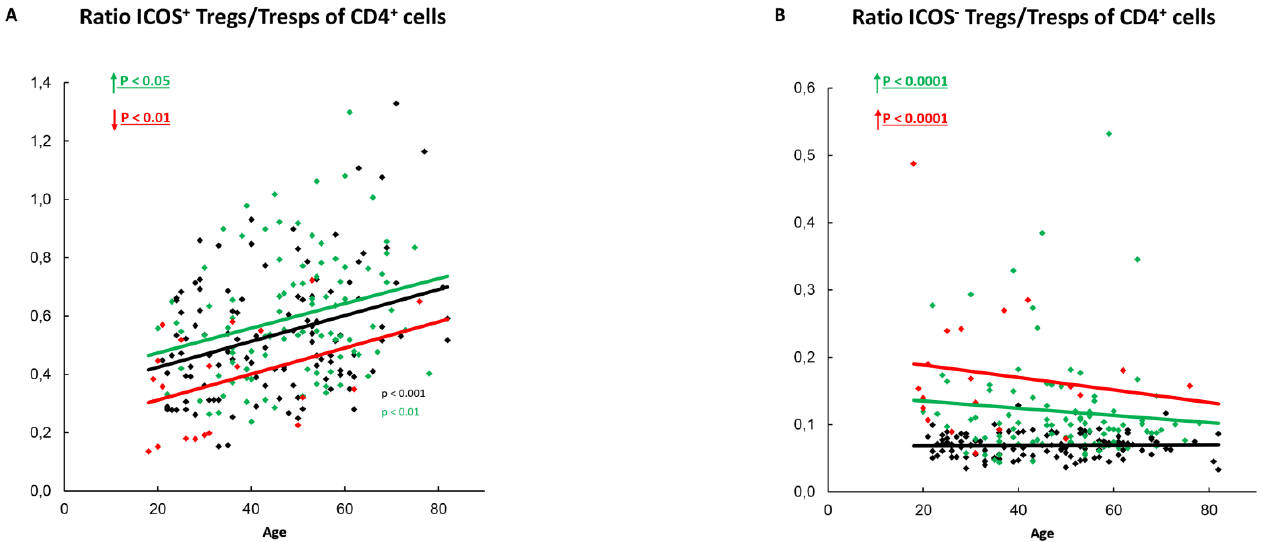
Figure 6. Ratio of ICOS + -Tregs/Tresps or ICOS − -Tregs/Tresps within total CD4 + -T-helper cells. The ratio of ICOS + - Tregs/Tresps ( A ) as well as the ratio of ICOS − -Tregs/Tresps ( B ) is shown for healthy controls (Black coulored), SLE patients in remission (Green coloured) and SLE patients with active disease (Red Coloured). The figures present the regression lines concerning the changes with age. Significant age-dependent changes are marked by black, green, or red p-values. Significant age-independent differences between healthy volunteers and SLE patients in remission or SLE patients with active disease are marked by green or red underlined P-values. Further information of the calculated p-values is illustrated in Table S1.